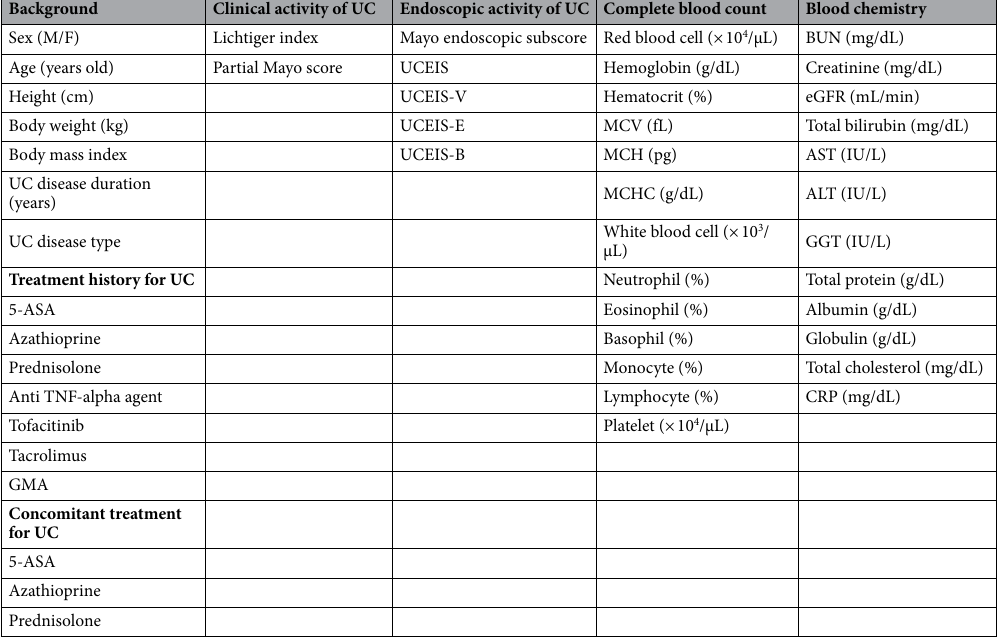
Table 1. Baseline clinical features employed for machine learning. UC ulcerative colitis, 5-ASA 5-aminosalicylic acid, TNF tumor necrosis factor, GMA granulocyte and monocyte apheresis, UCEIS